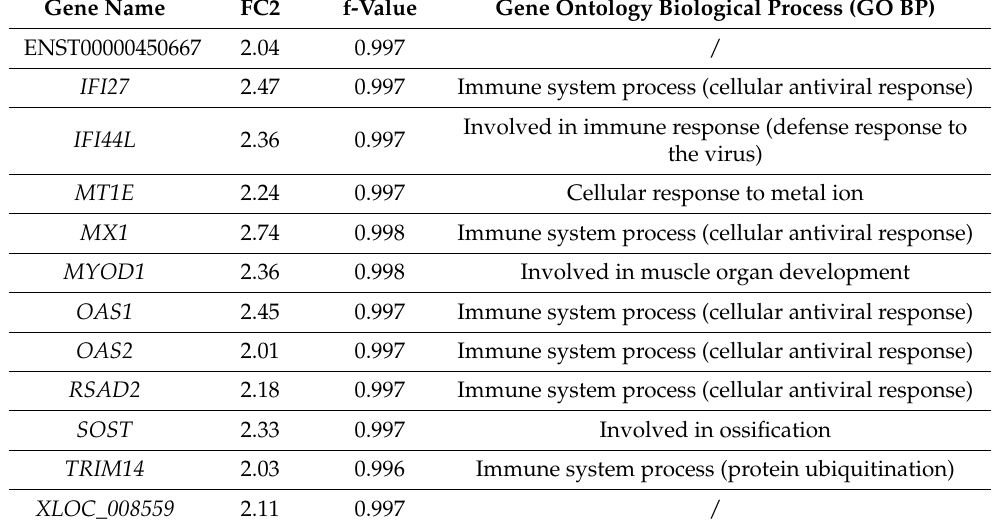
Table 1. Saos-2 cells exposed on the rough surfaces of Y-TZP discs for 96 h (f-value ≤ |0.01).